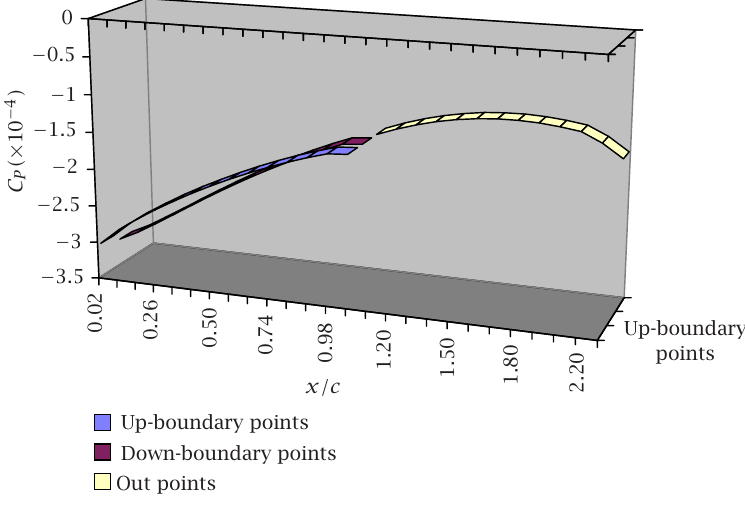
Figure 6.4 . Pressure distribution (3D form) around the aircraft of Figure 5.1, for linear vortex distribution and speed